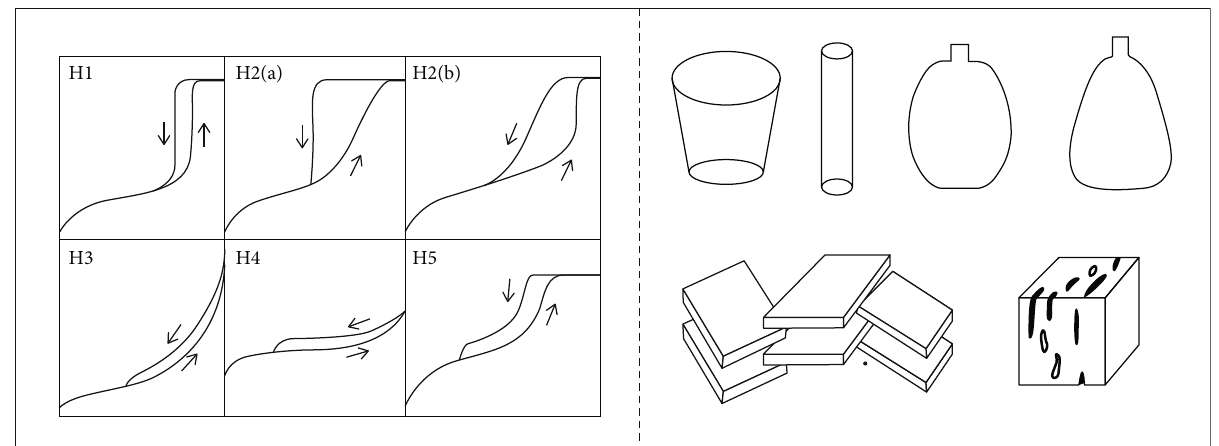
Figure 5: Hysteresis loops and their corresponding pore